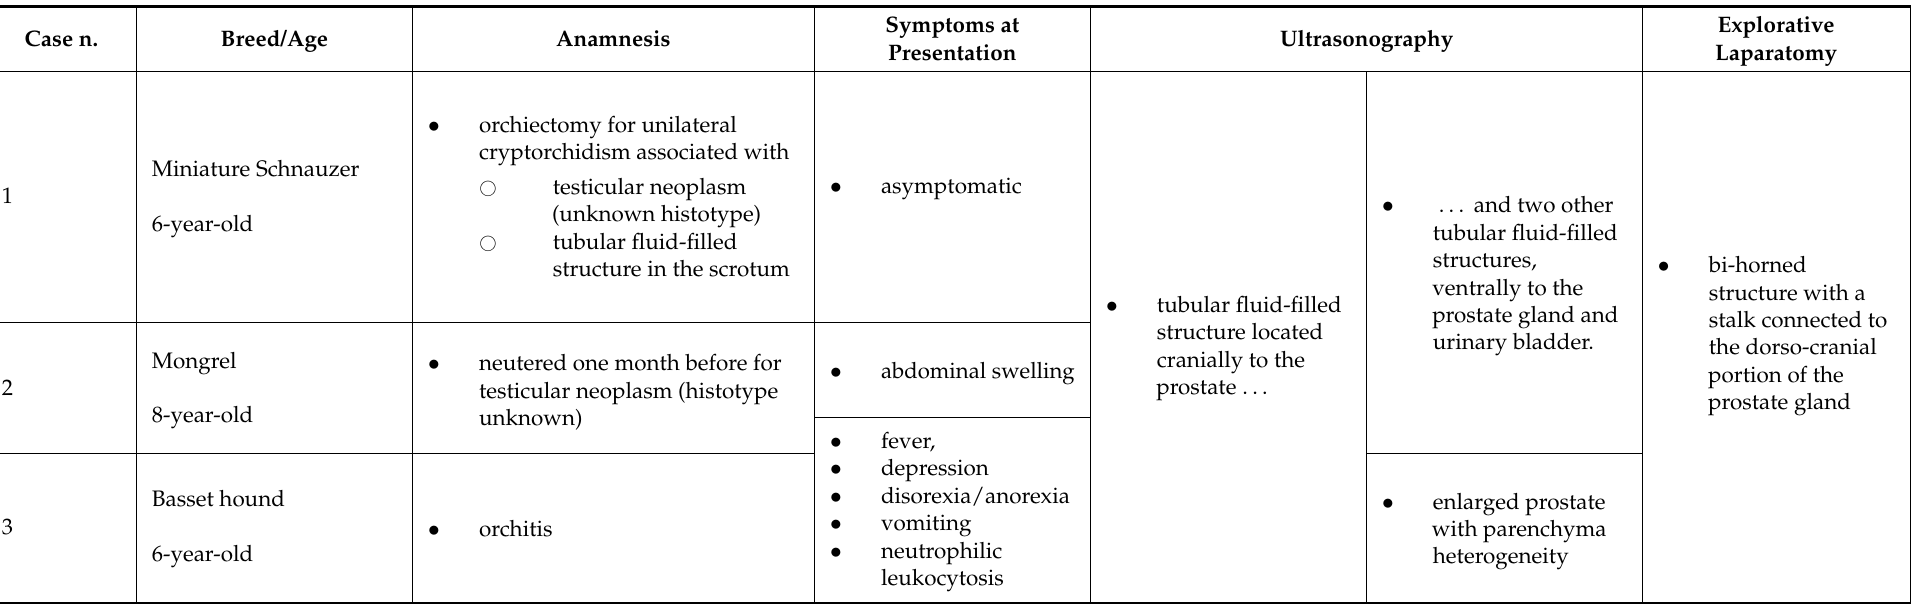
Table 1. Anamnesis, symptoms at presentation and analogies/differences of ultrasonographic and laparotomic investigations in the three dogs with a final clinical diagnosis of uterus masculinus